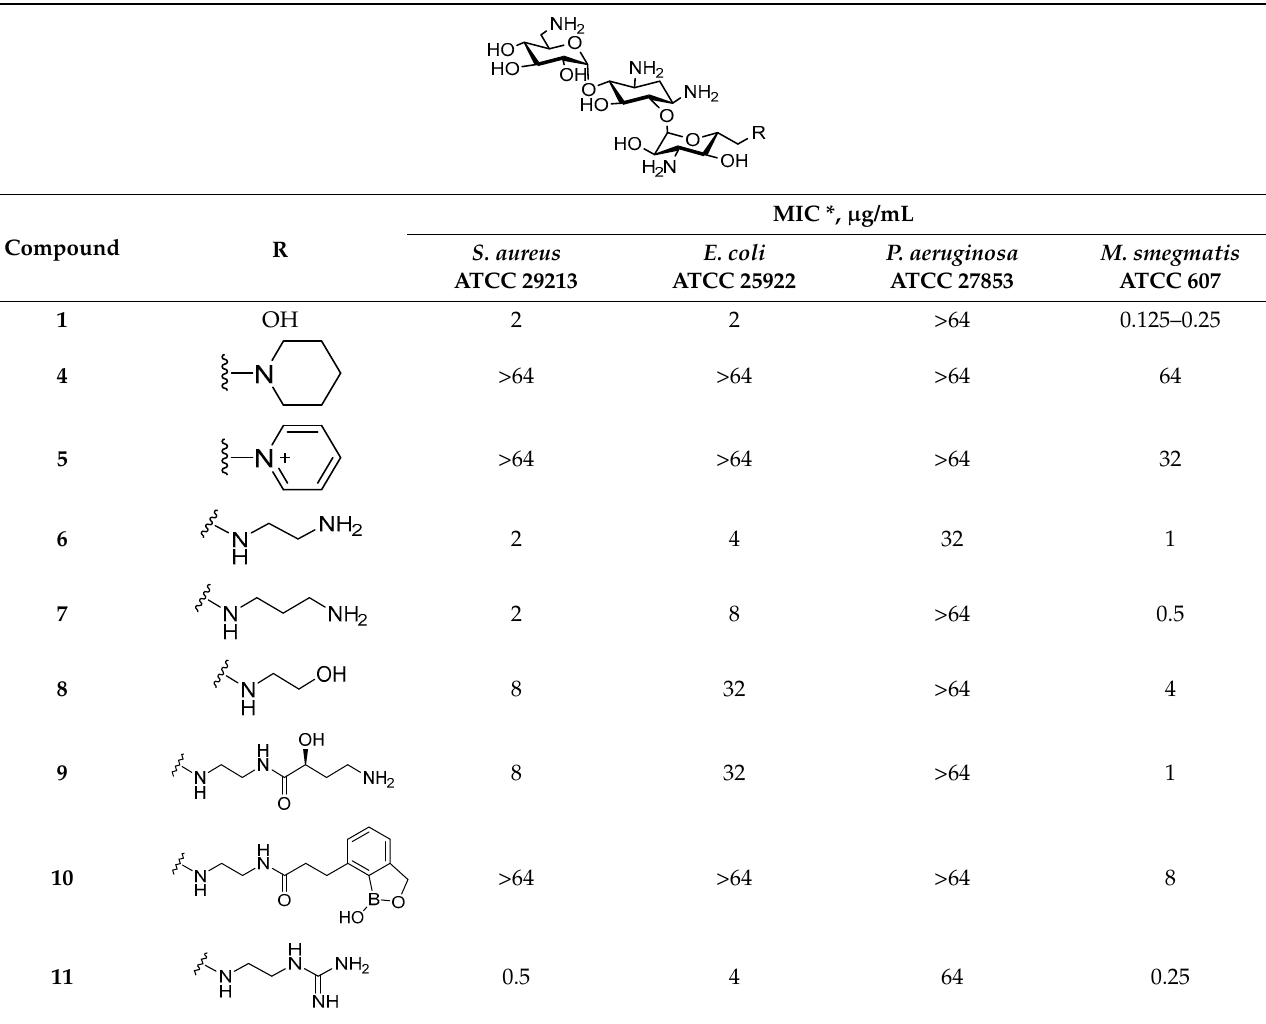
Table 1. Antibacterial activity of the new obtained kanamycin derivatives 4 – 11 in comparison with the KANA ( 1 ).